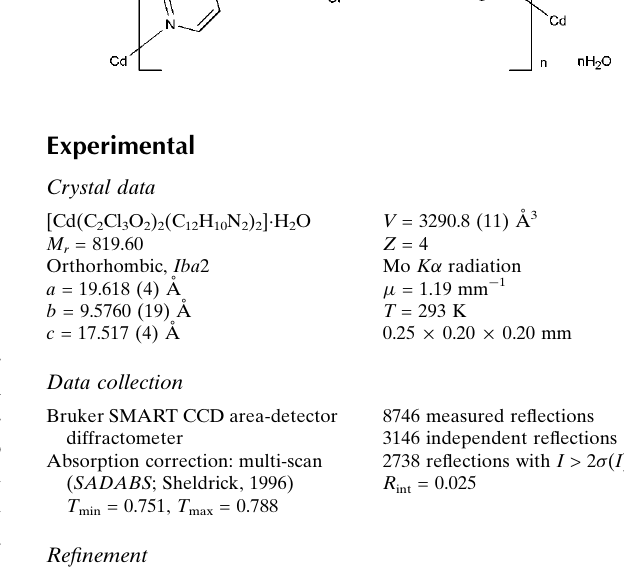
Bruker SMART CCD area-detector diffractometer Absorption correction: multi-scan ( SADABS ; Sheldrick, 1996)